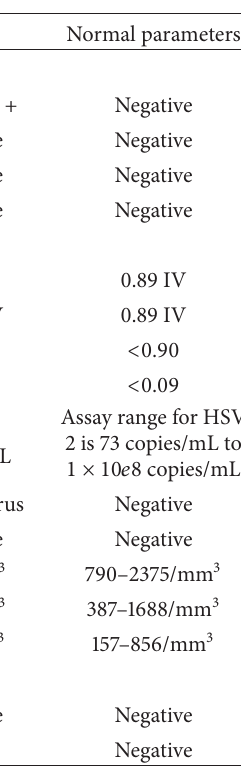
Table 1: Summary of patient’s microbiology